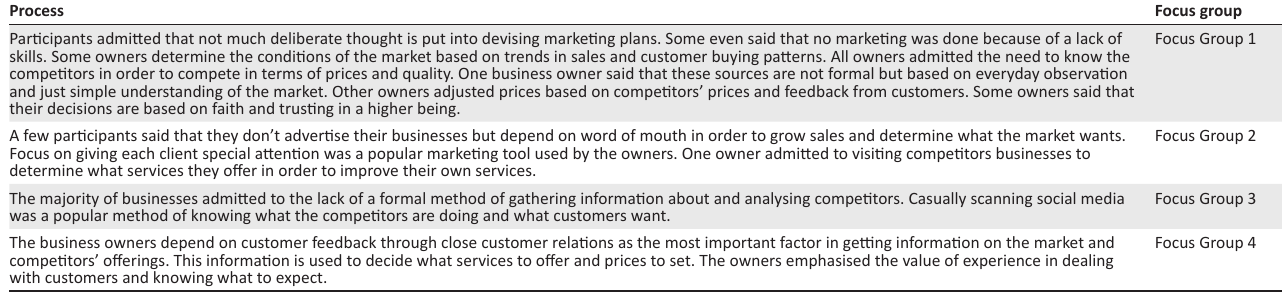
TABLE 2: Focus group samples of the strategic decision-making process in the context of the market.